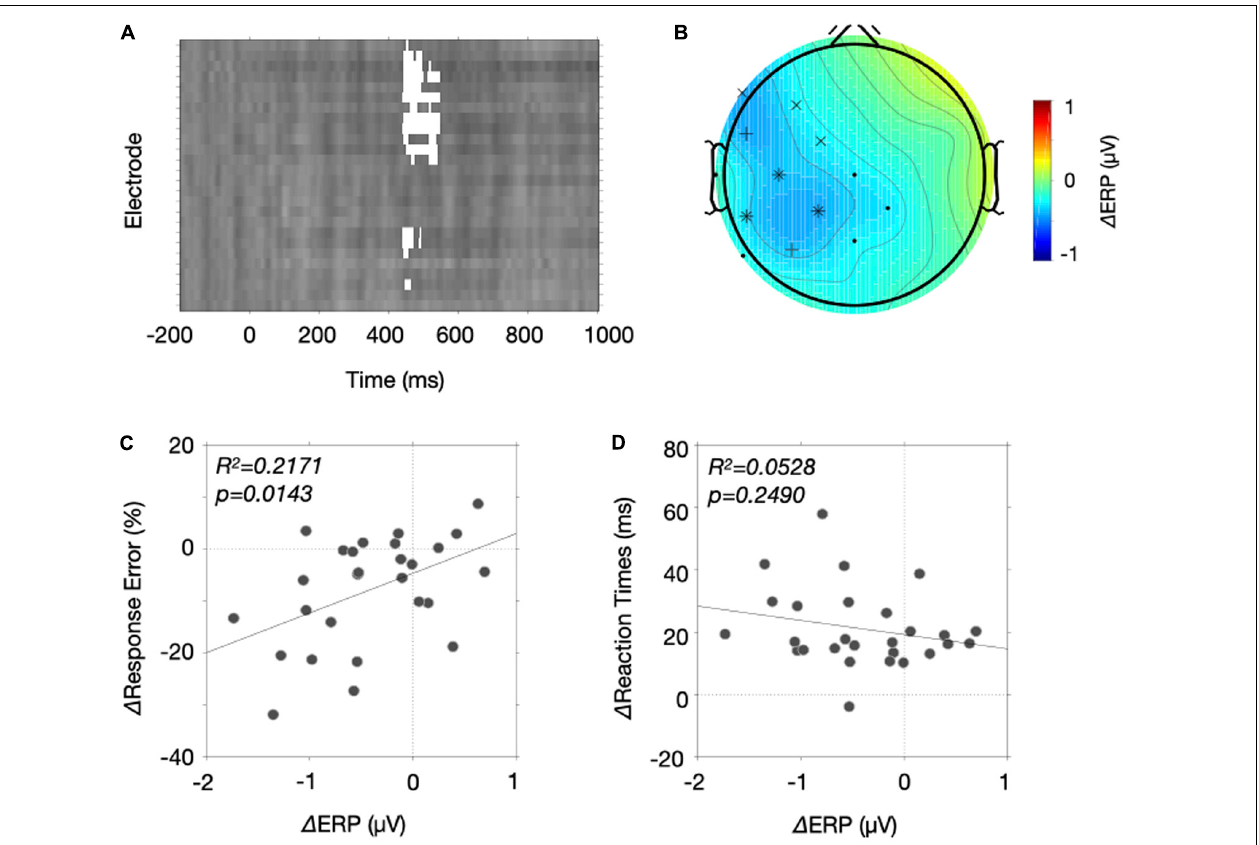
FIGURE 4 | Results of the mass univariate approach. (A) A map of significant differences (white boxes) is drawn for each electrode as a function of time. The 26 electrodes were arranged from the top to bottom in order of Fz, F3, F7, FC5, FC1, C3, T7, CP5, CP1, Pz, P3, P7, O1, Oz, O2, P4, P8, CP6, CP2, Cz, C4, T8, FC6, FC2, F4, and F8. The brightness changes indicate the ERP differences between the two probability conditions. (B) The temporal extent of the significant differences of an electrode was plotted on its position. We only selected electrode whose significance differences longer than 20 ms throughout 0.2–1.0 s (* for ≥ 100 ms, + for ≥ 80 ms, x for ≥ 40 ms, • for ≥ 20 ms). The ERP differences between 450 and 550 ms were color coded to aid the interpretation. (C,D) Correlation between the ERP differences and the behavioral differences. (C) The response error differences of the stop-signal trials were plotted as a function of ERP differences between the two probability conditions. The solid line indicates a fitted line. (D) The reaction time differences of the stop-signal trials were plotted as a function of ERP differences between the two probability conditions. The solid line indicates a fitted